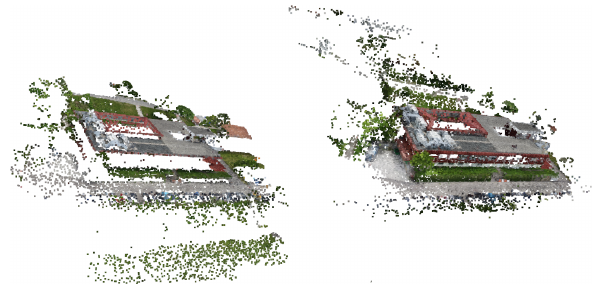
Figure 1. Two point clouds of the same building. The point clouds with RGB texture are derived by 3d reconstruction from nadir views (left) and from oblique views (right).